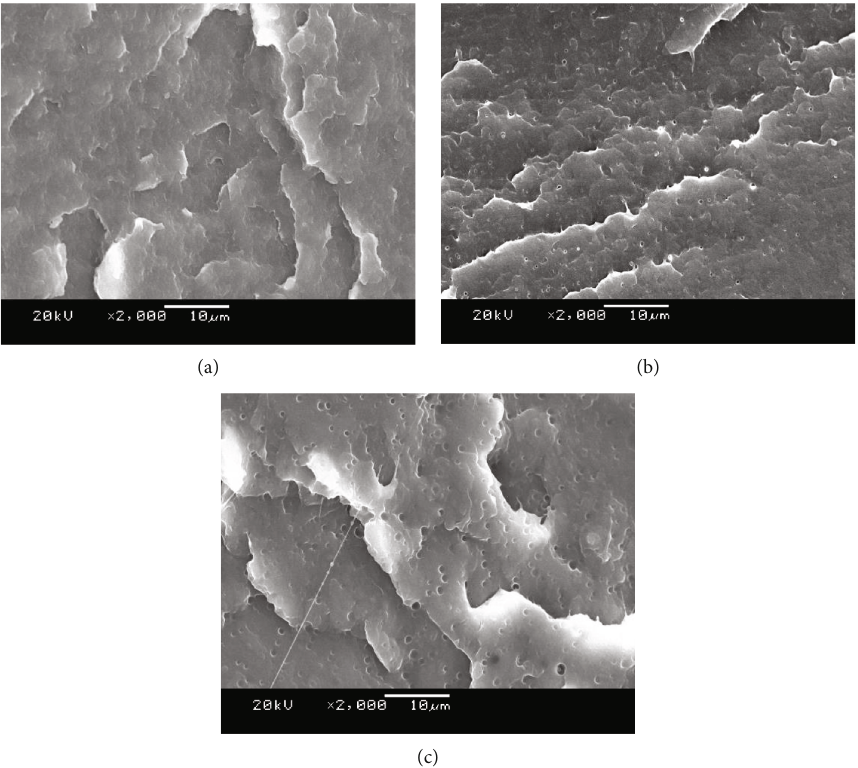
Figure 4: SEM of PLA (a), ERO bioblend (b), and EERO bioblend (c).